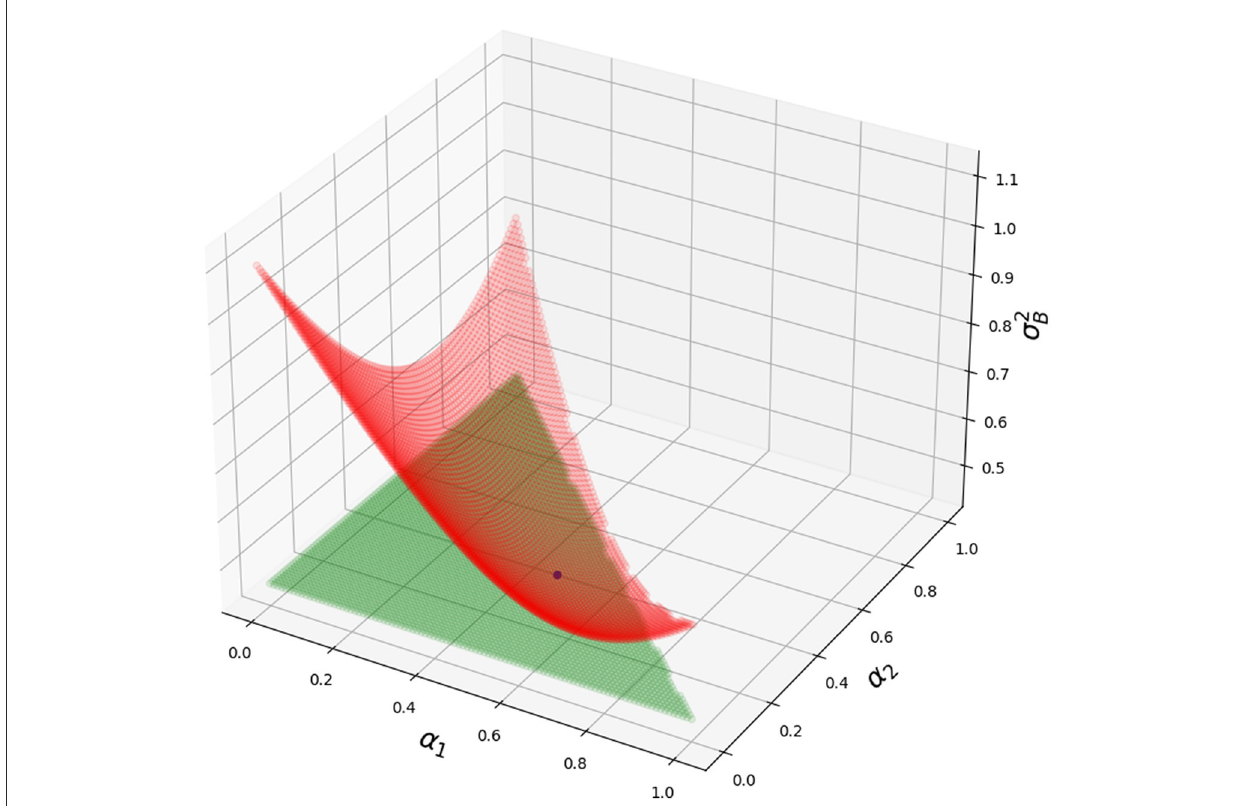
FIGURE2 Grid consisting of red dots—variance for different α 1 and α 2 . Grid consisting of green dots—optimal variance σ 2 B . Blue dot—optimal α 1 and α 2 and 1 − α 1 − α 2 with its value σ 2 B ( ˆ α ). Python script is in Appendix 2.